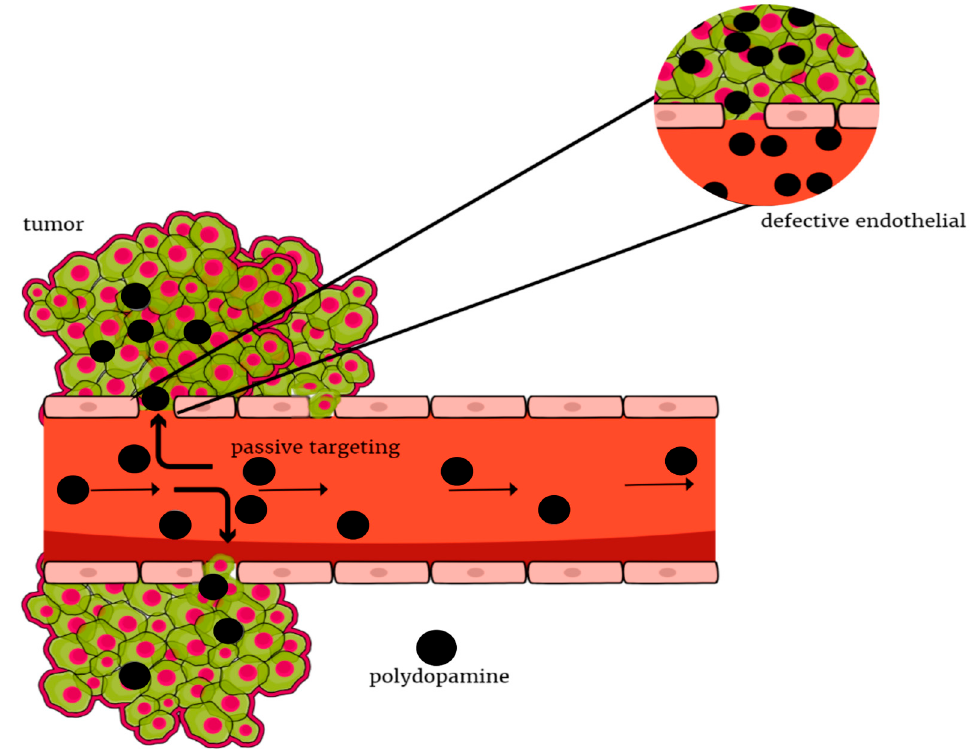
Figure 2. Polydopamine-based materials allowing for passive accumulation of therapeutic agents within tumors via the EPR effect.